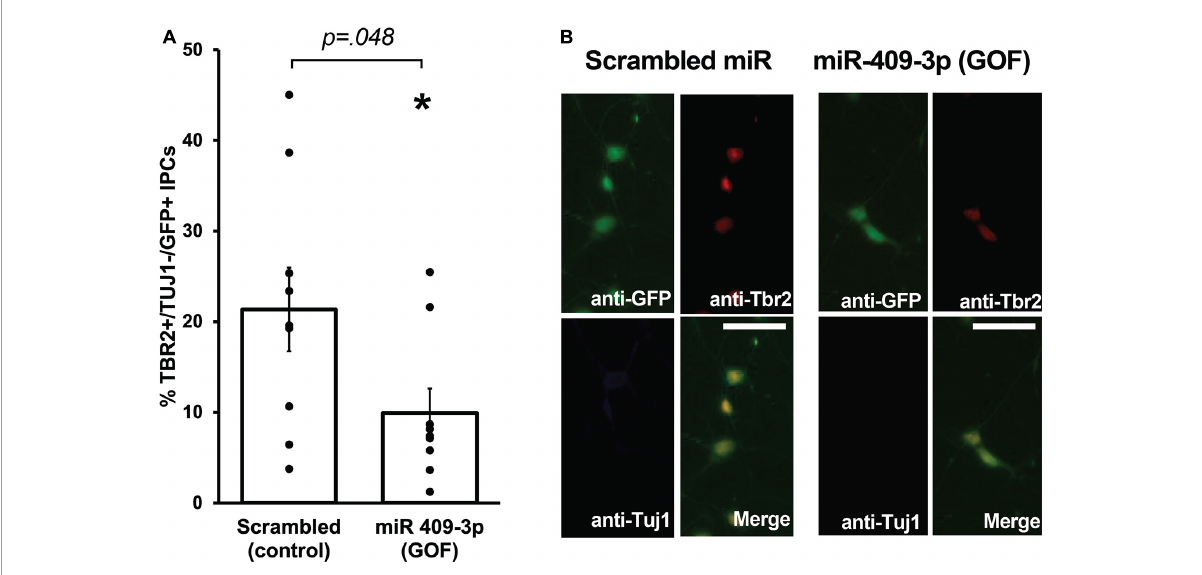
FIGURE2 miR-409-3p represses intermediate progenitor cell proliferation in primary culture. (A) miR-409-3p overexpression gain-of-function (GOF) decreases the percent Tbr2 + /Tuj1-/GFP + IPCs compared to scrambled control in embryonic cortical cultures. (B) Representative fluorescence micrographs of embryonic cortical cultures illustrate a decrease in the percent Tbr2 + /Tuj1-/GFP + IPCs with miR-409-3p GOF. Scale bar, 50 µ m. Each dot depicts an independent biological replicate. * p < 0.05 (Two-tailed t -test).